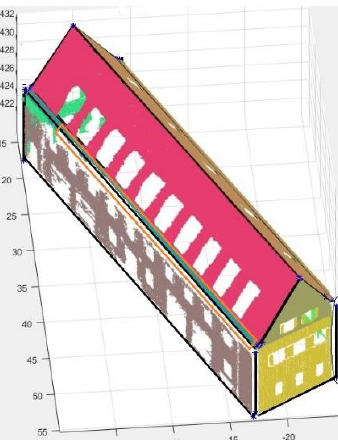
Figure 4. Candidates of vertices and produced intersected lines